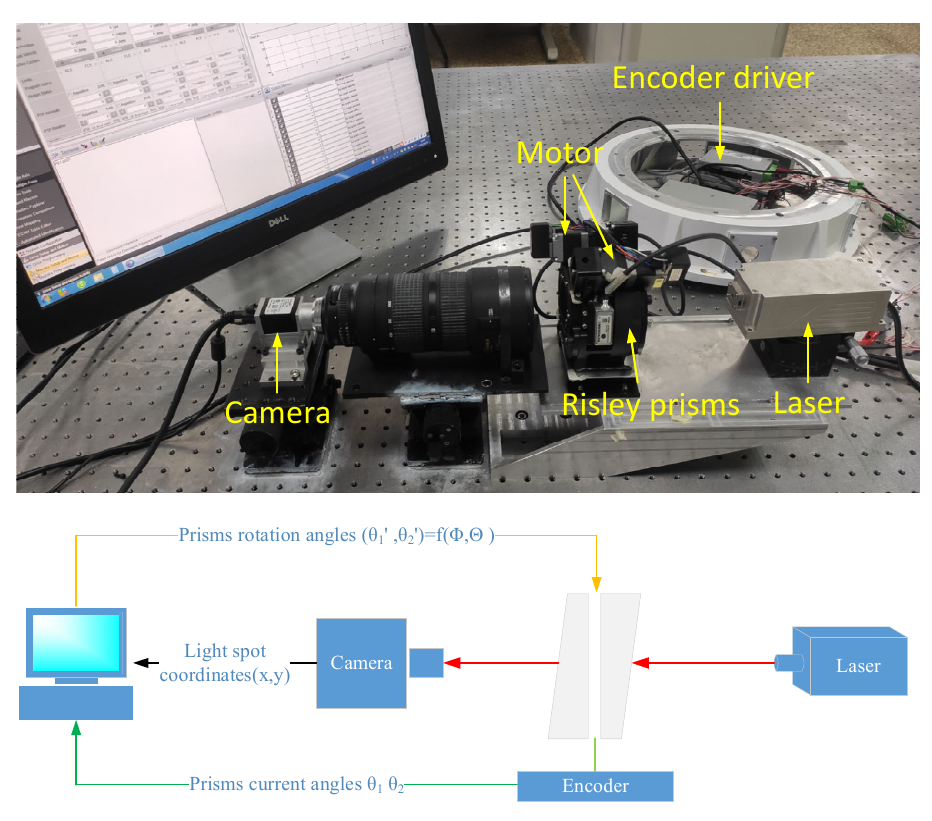
Figure 11. Experimental platform and schematic diagram.